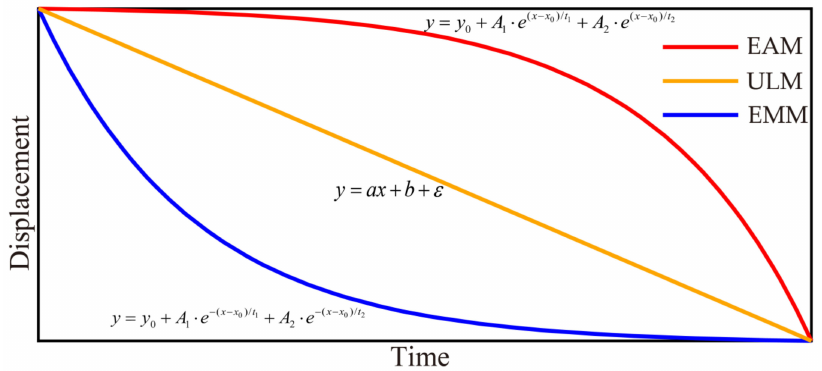
Figure 3. Development trend model of the deformation